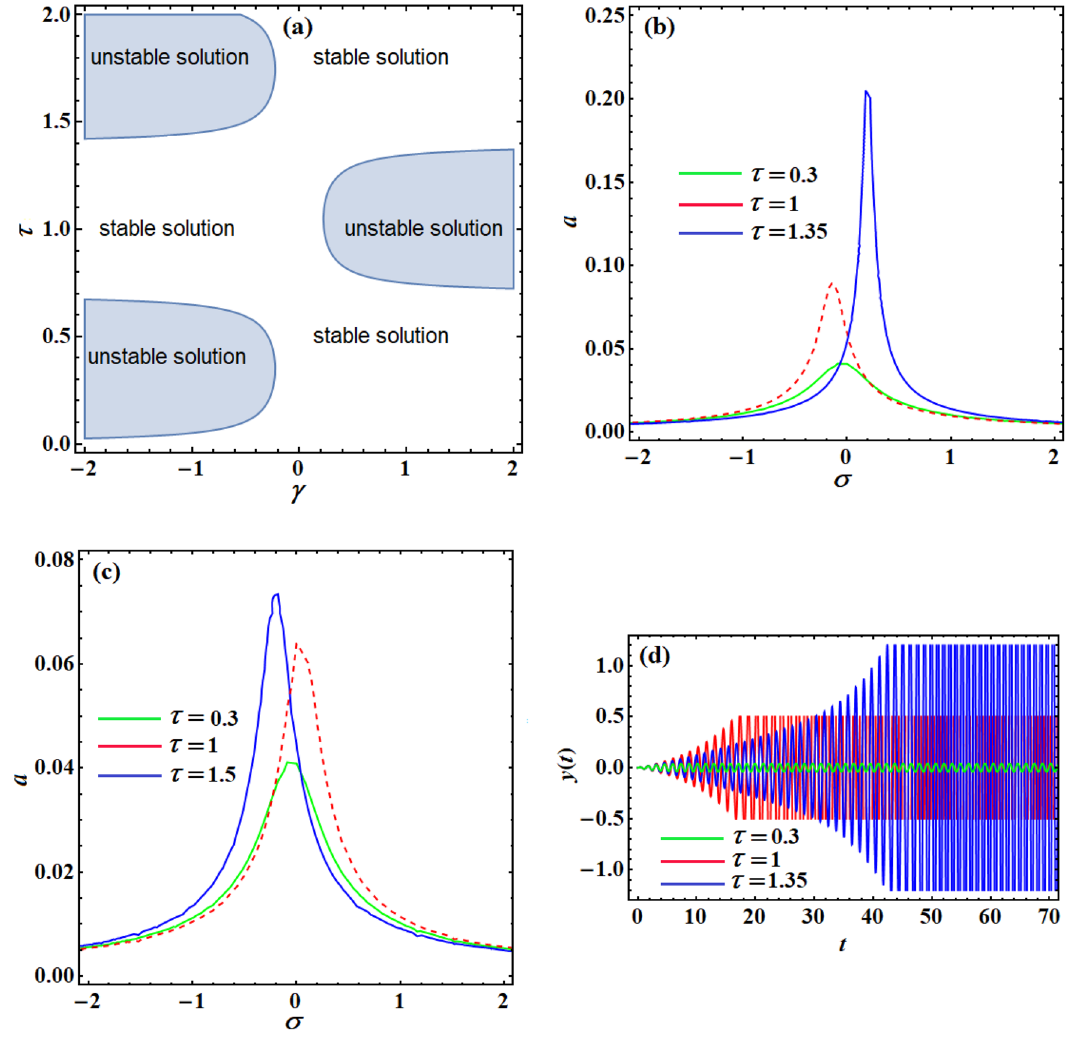
Figure 10. ( a ) Represents the stable and unstable solution zone in (γ − τ) plane at F = 0.1, σ = (cid:31) = 0 , ( b ) displays the system frequency–response curves when γ = − 1, F = 0.1, (cid:31) = 0 at different time-delay values, ( c ) reveals the system frequency–response curve when γ = 1, F = 0.1, (cid:31) = 0 at various values of time-delay parameter, and Fig. 10d describes the time response of system when γ( = − 1, 1 )